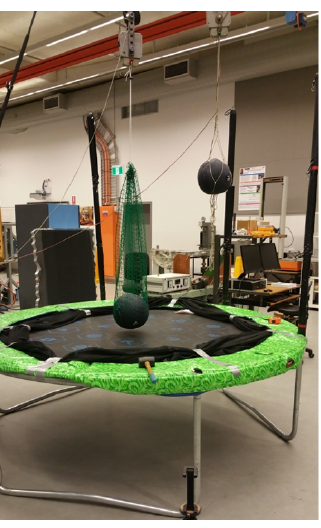
Figure 11. Experiment setup depicting the two medicine balls and their respective bomb release